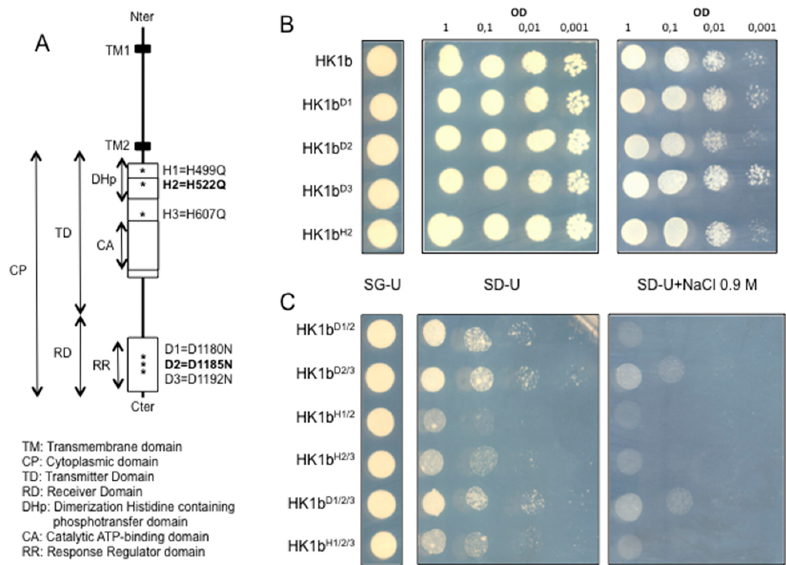
Figure 8. Functional complementation with HK1b mutants. ( A ) Schematic representation of HK1b with the different domains as indicated. All mutated positions are indicated with an asterisk and the corresponding mutated sequences shown on the right. The putative canonical histidine and aspartate residues are in bold; ( B ) Wild-type and single mutation constructs of HK1b were introduced into the osmodeficient strain (MH179) as indicated and spotted onto different media at a density corresponding to an OD 600 = 1 and three 10-fold dilutions as indicated. The resulting transformants were spotted onto SG-Ura medium for growth control and onto SD-Ura medium for growth rescue. Finally, transformants were spotted onto SD-Ura+NaCl media with increasing concentrations of NaCl for the osmotic tolerance test; ( C ) Double and triple mutation constructs of HK1b were introduced into the osmodeficient strain (MH179) as indicated and spotted onto different media at a density corresponding to an OD 600 = 1 and three 10-fold dilutions as indicated. The resulting transformants were spotted onto SG-Ura medium for the growth control and onto SD-Ura medium for growth rescue. Finally, transformants were spotted onto SD-Ura+NaCl medium with 0.9 M of NaCl for the osmotic tolerance test.